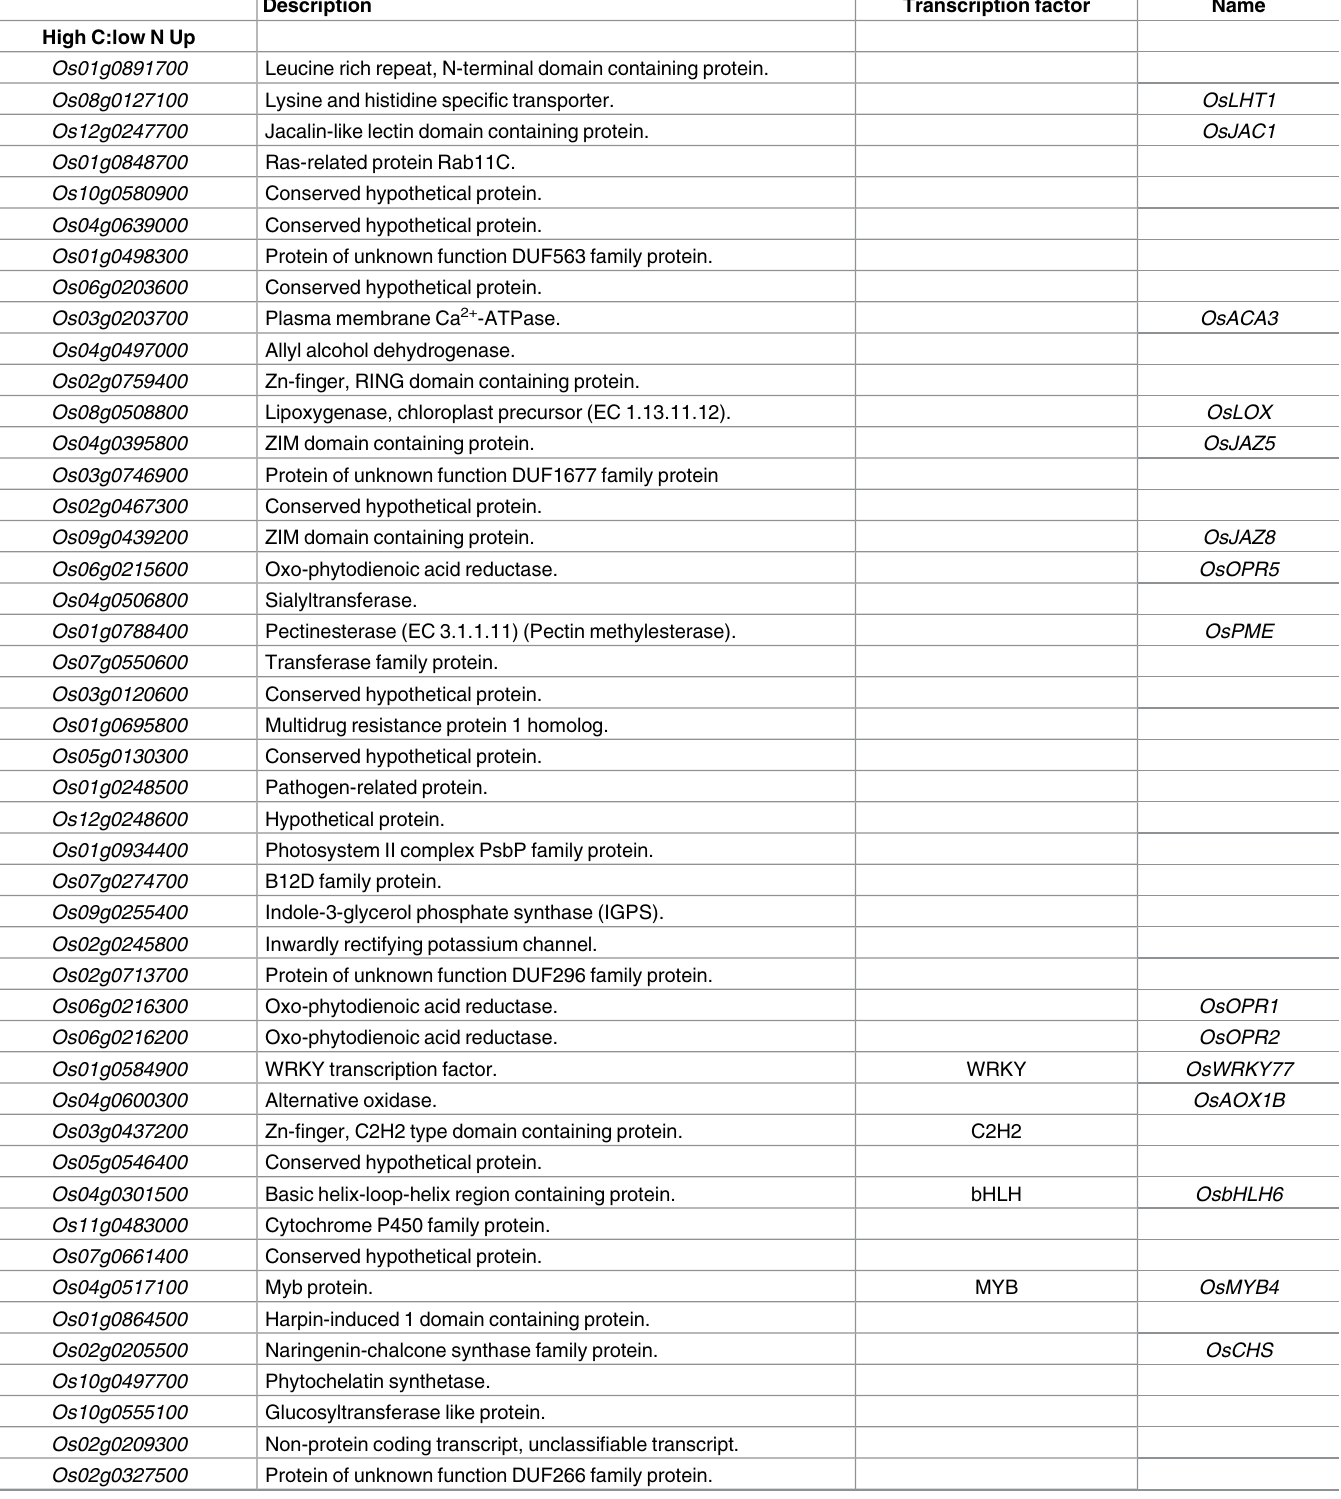
Table 1. Annotations of genes responsive to imbalanced high C:low N and low C:high